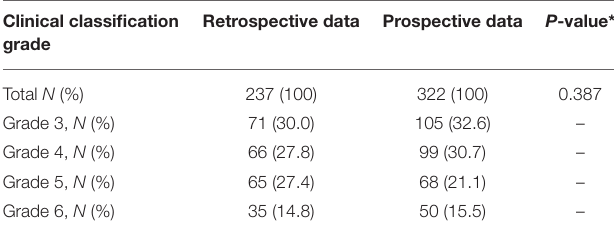
TABLE 2 | Clinical classifications of cases in retrospective and prospective